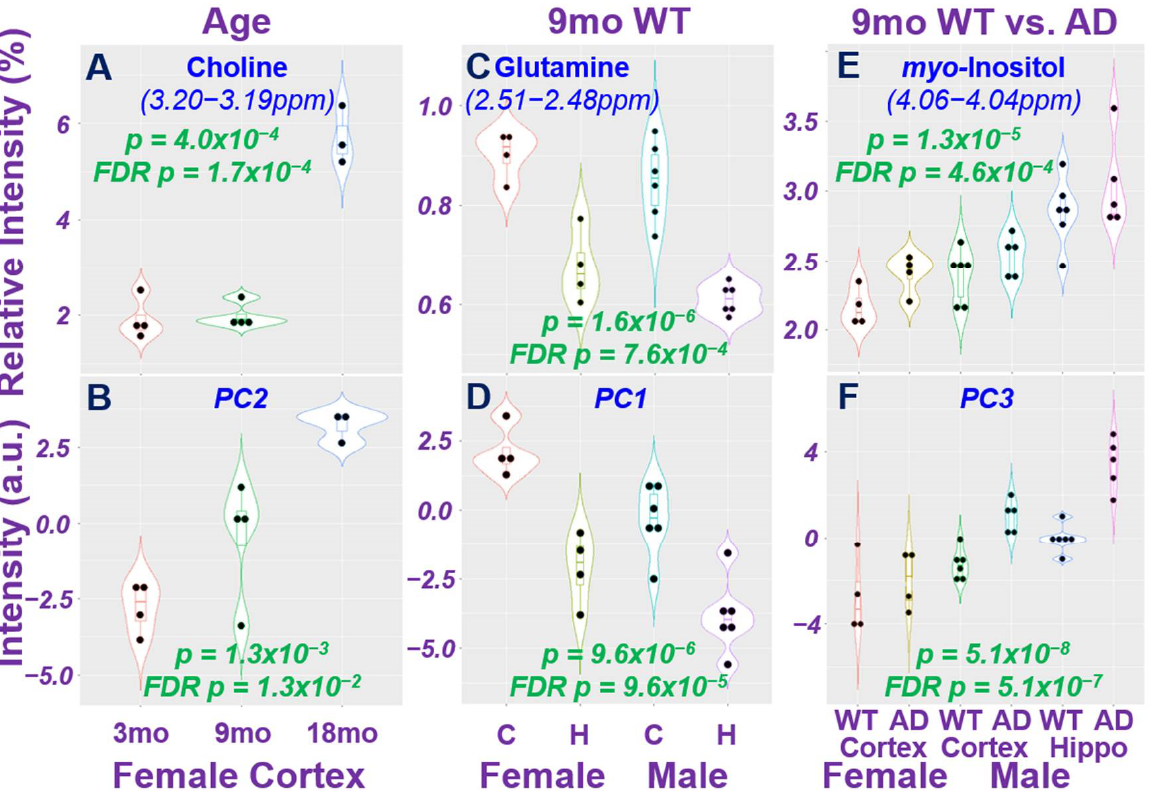
Figure 2. Differentiations of Animal Age, Brain Region, and AD Status using Individual Spectral Regions, and Principal Component as Metabolomics Profiles. Both original p -values and p -values after FDR corrections are presented in each plot. Mo, month; C, cortex; H, hippocampus; a.u., arbitrary unit.